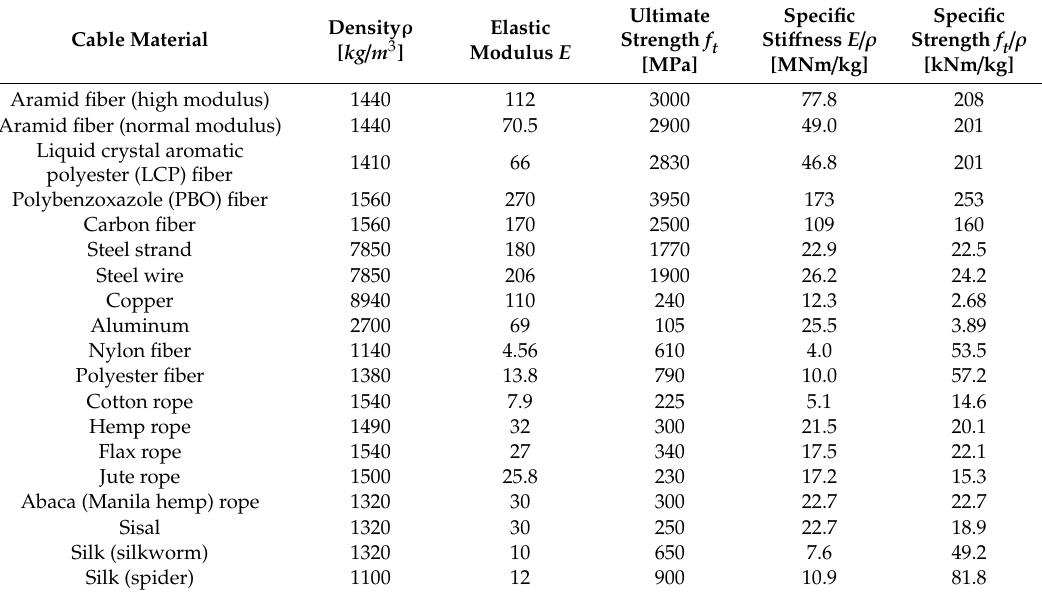
Table 1. Reference values of relevant mechanical properties of various cable materials.